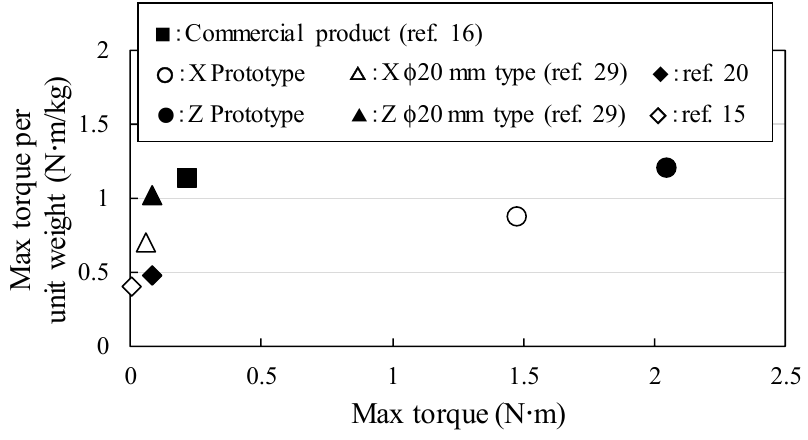
Figure 16. Comparison of maximum torque and torque per unit weight for various MDOF-SUSMs.